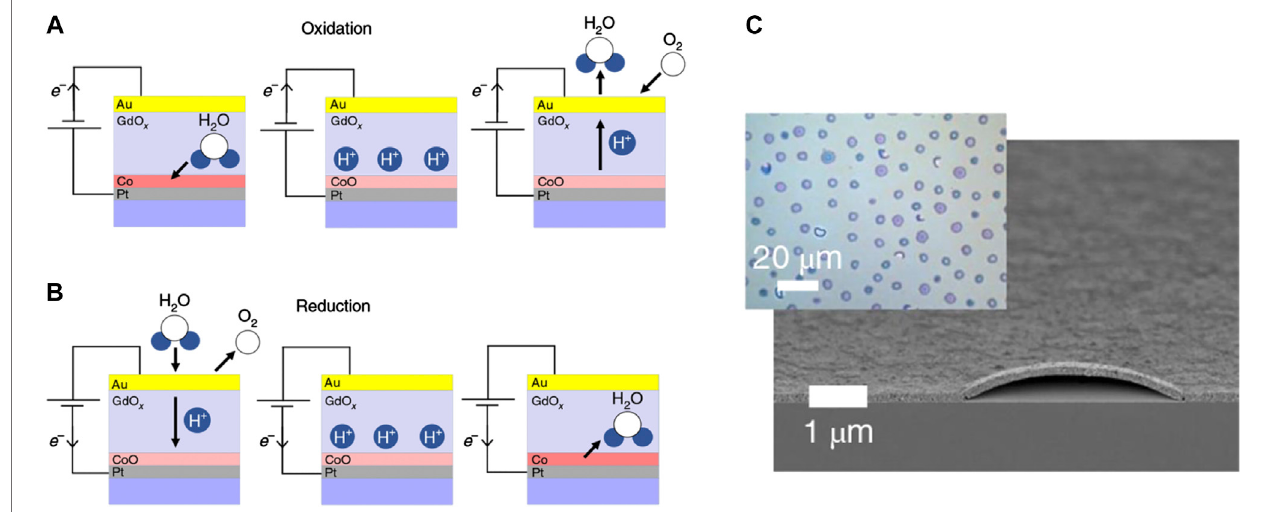
FIGURE 5 | (A,B) Schematic diagram of Co/GdOx heterostructure and ongoing electrochemical reactions (Tan et al., 2019). (A) Applying a negative bias voltage causes an oxidation reaction at the anode: Co will be transformed into non-magnetic CoO material, and the magnetism will be eliminated; (B) Applying a positive bias voltage causes a reduction reaction at the cathode: CoO is converted into metal Co, recovering perpendicular magnetic anisotropy across the Co/GdOx interface; (C) Cross-sectional scanning electron microscope image of hydrogen accumulation after the positive bias voltage is continuously applied. (A – C) Reprinted with permission from Tan, A.J., Huang, M., Avci, C.O., Büttner, F., Mann, M., Hu, W., et al. (2019). Magneto-ionic control of magnetism using a solid-state proton pump. Nature materials 18 (1), 35 – 41. Copyright 2019